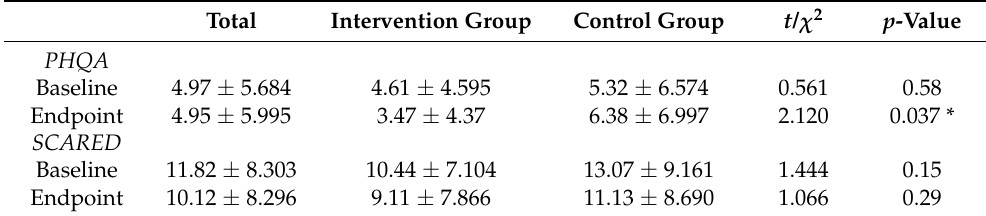
Table 2. Means and standard deviations for outcome